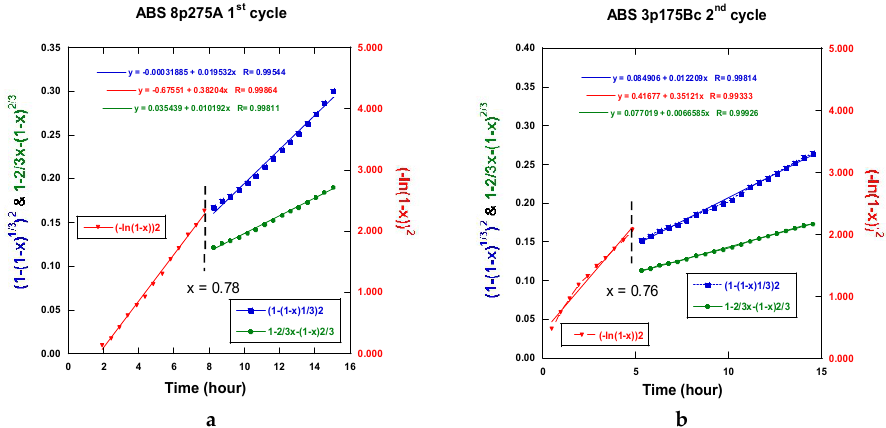
Figure 32. Numerical fits using Equation (1) at the beginning absorption for (2) and (3) at the end of absorption: ( a )—for eight passes A mode treated at 275 ◦ C, the 1st cycle absorption, ( b )—for three passes B C mode treated at 175 °C, the 2nd cycle absorption.